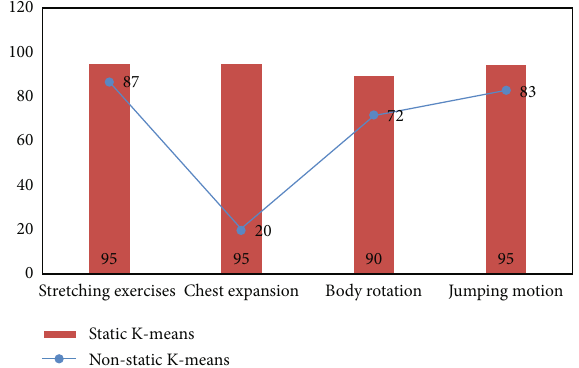
Figure 6: Mean performance of di ff erent datasets on the test